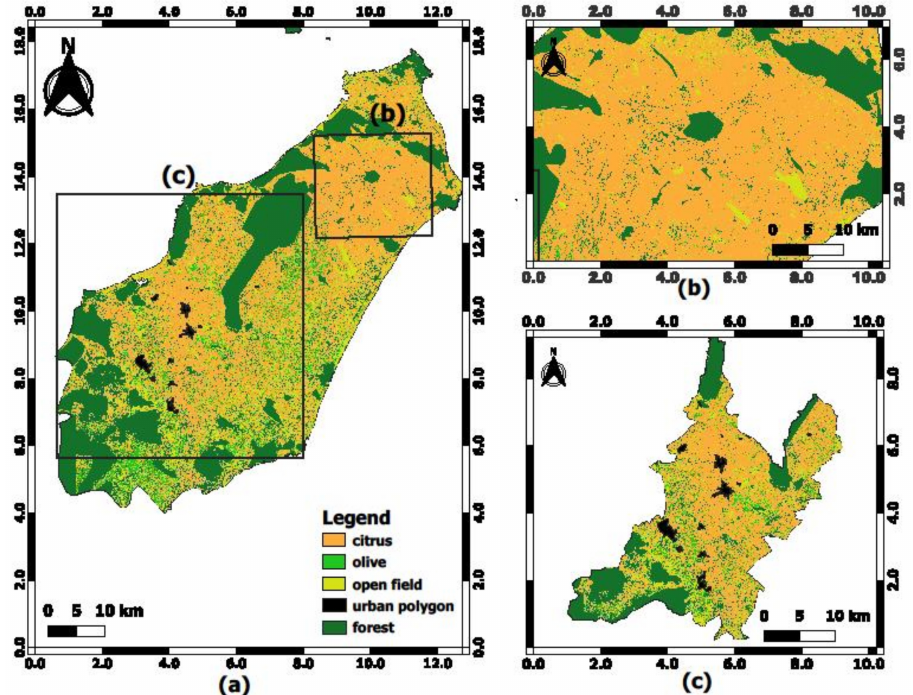
Figure 9. ( a ) Visualization of the classification results with the M6 classifier within the second scenario (NDVI + VV + VH) at the level of the whole Cap Bon region; and ( b ) zoom on the area marked by the ( b ) square located in northeast of the region; and ( c ) zoom on the area marked by the ( c ) square located in southwest of the